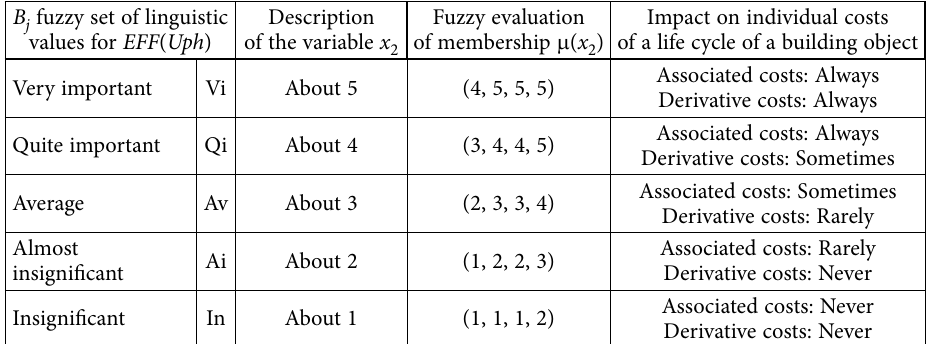
Table 3. Fuzzy interpretation of the linguistic input variable x 2 – EFF(Uph) B j fuzzy set of linguistic values for EFF ( Uph